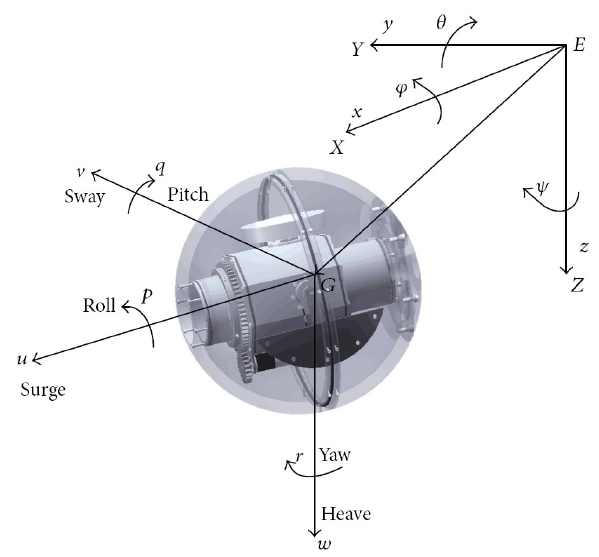
Figure 1. Earth-fixed and body-fixed coordinate